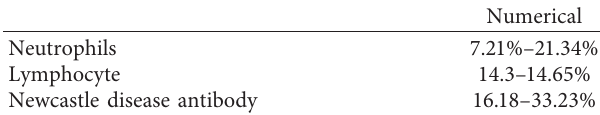
Table 2: Blood analysis specific data.